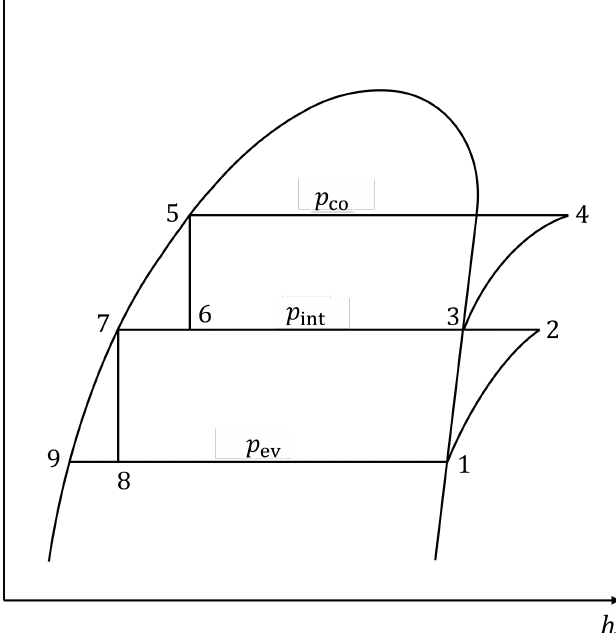
Figure 2. Thermodynamic states of the working fluid in the refrigeration cycle. For the interpretation of the numbers please refer to Figure